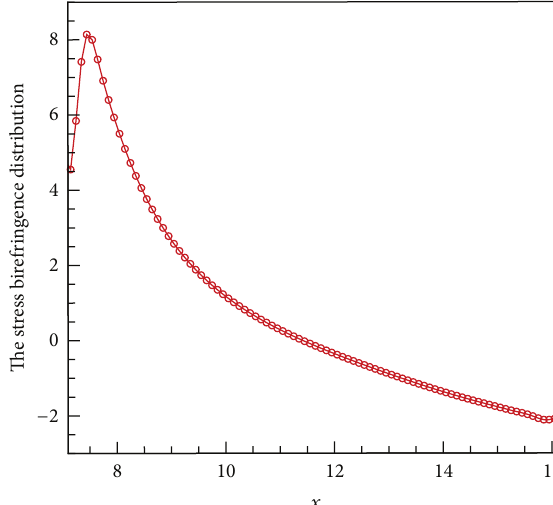
Figure 5: The distribution of the stress birefringence at 𝑡 = 1.05 in the simulation.